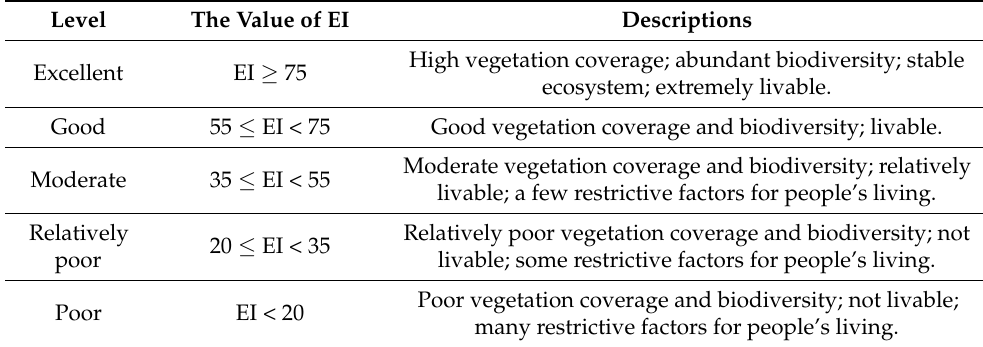
Table 3. Grading standards of the eco-environmental status.